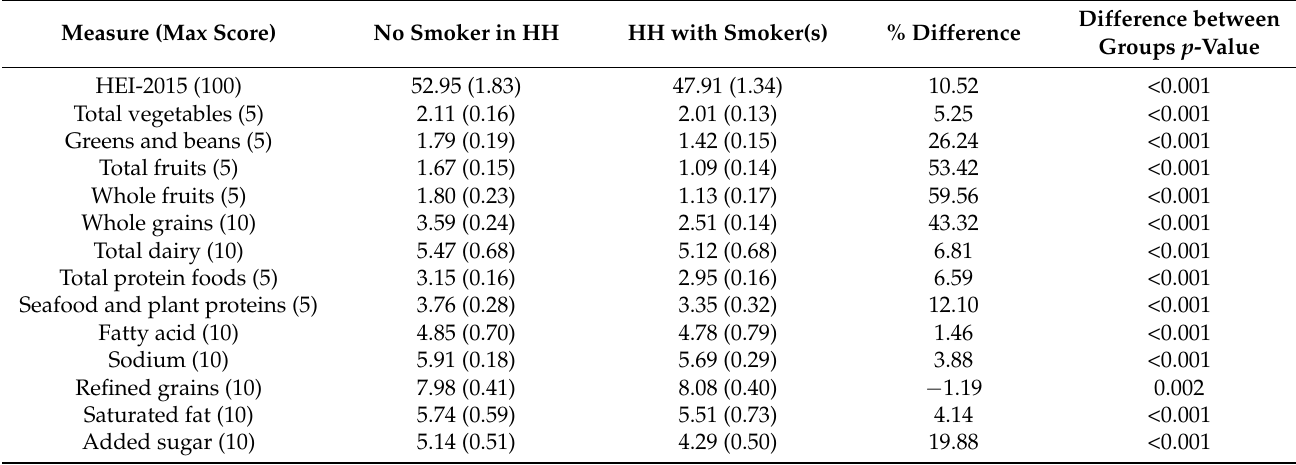
Table 6. Adjusted weighted mean HEI-2015 and component scores (standard deviations) for households with and without a member reporting smoking, based on CN 2015-MedpProfiler